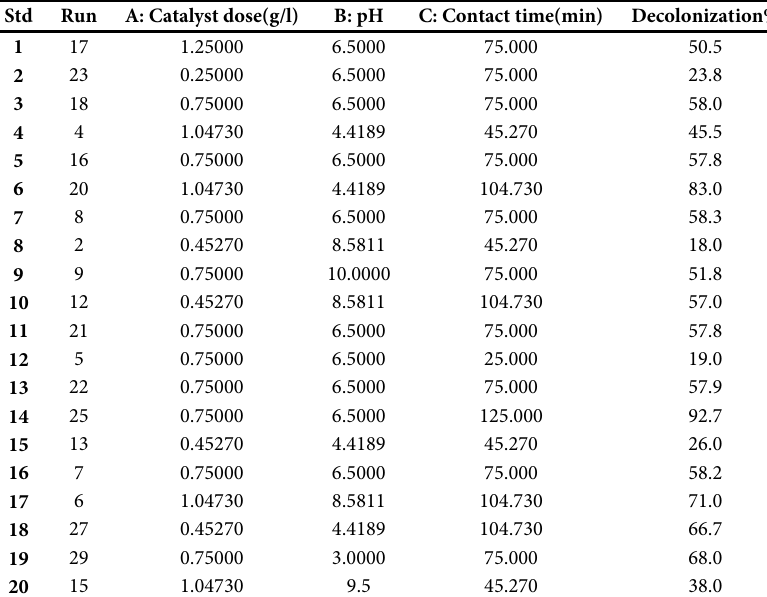
Table 4. Design of experiments and actual and predicted values for decolorization of